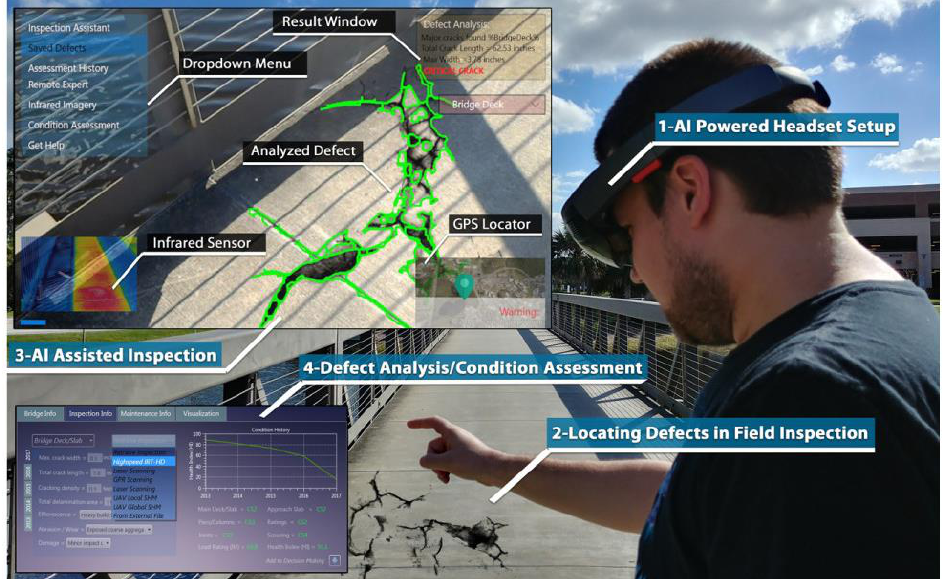
Figure 18. Visual representation of the AI-supported AI framework [11].